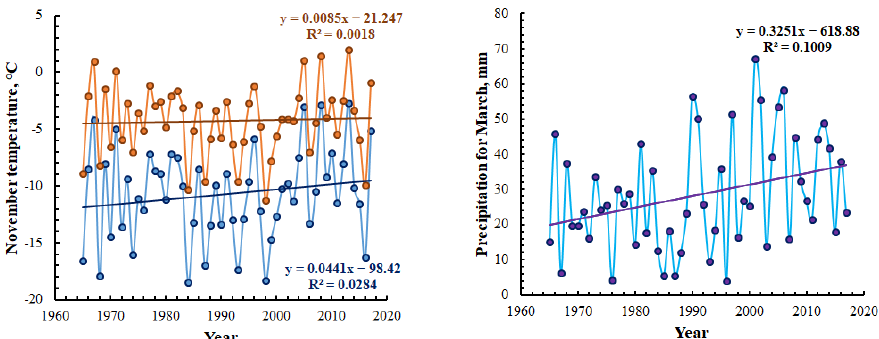
Figure 8. Multi-year monthly trend in temperature and precipitation pattern for which statistically significant relationship was found: The upper and lower lines show the corresponding maximum and minimum